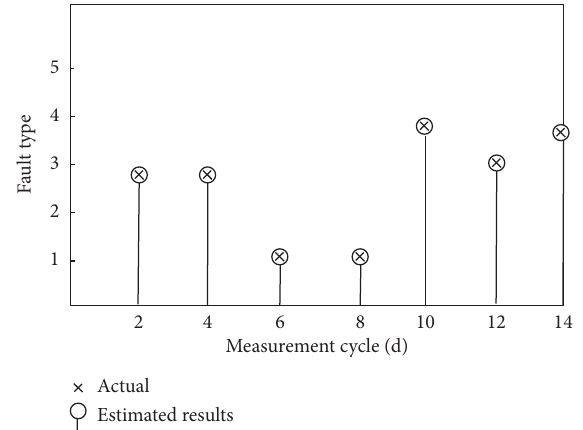
Figure 5: IEEE 30 bus power system state estimation